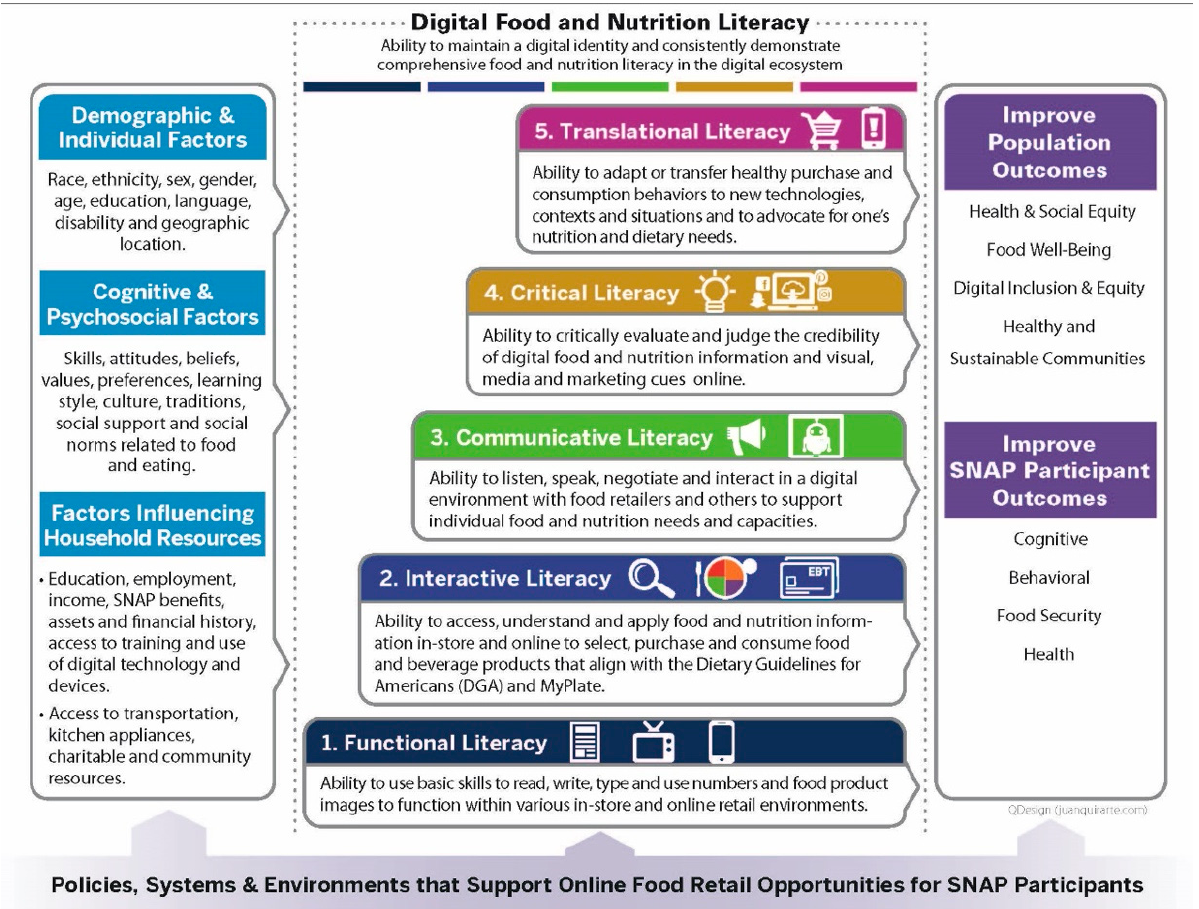
Figure 1. Multi-dimensional Digital Food and Nutrition Literacy (MDFNL) model to support SNAP adults to make healthy purchases in an online food retail ecosystem [49].